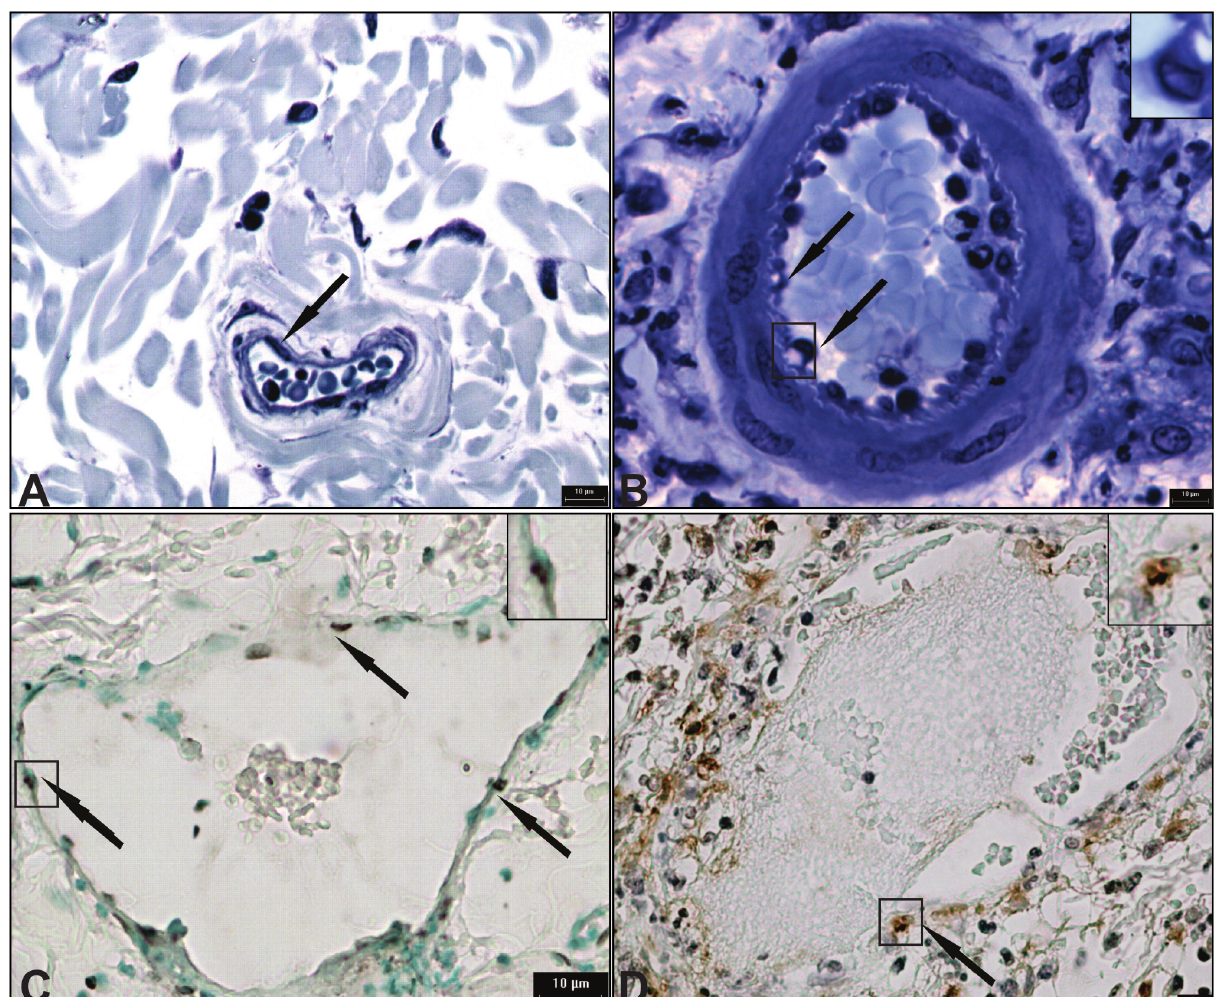
Figure 6. Microscopic picture of rabbit skin: ( A ) control group – blood vessel – endothelial cell (black arrow); ( B ) apoptotic endothelial cells (black arrows), (details – insertion on the top right corner); ( C ) experimental group, two hours after venom injection – presence of apoptotic endothelial cells, labeled positive with TUNEL reaction (black arrow) (details – insertion on the top right corner); ( D ) experimental group – two hours after venom injection – positive cells for TUNEL reaction in the thrombus-vessel interface (details – insertion on the top right corner). Stainings: toluidine blue (A and B) and TUNEL reaction (C and D) DAB chromogen counter-stained by methyl green . Bar = 10